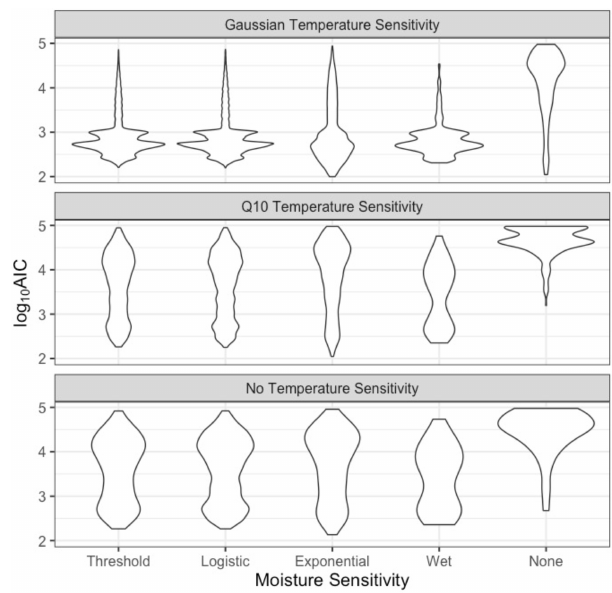
Figure 6. Frequency distribution of model performance (log 10 AIC scores) for each model combination of temperature and moisture sensitivities. Each observation represents one parameter combina- tion after constraining as described in Table 2. Lower log 10 AIC scores denote better model fit to the data. This figure only shows models constrained using realistic parameter estimates described in Table 2 ( n =